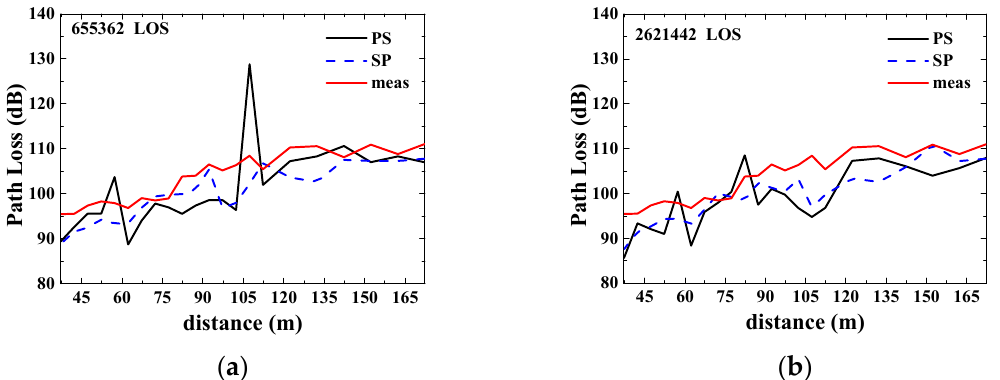
Figure 9. Path loss comparison of theoretical calculation with measured data for 655,362 and 2,621,442 rays in the LOS, respectively. ( a ) The number of rays is 655,362 ( b ) The number of rays is 2,621,442. Table 2. The RMSE in the LOS.